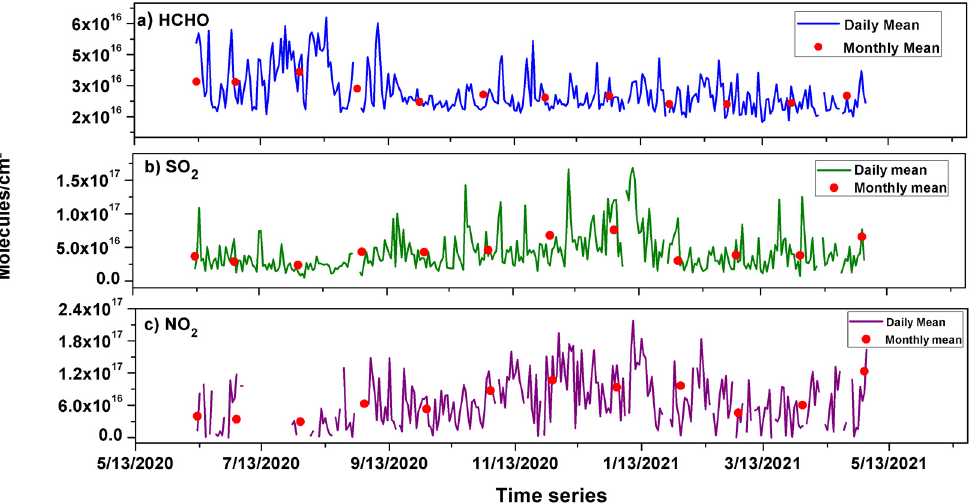
Figure 2. Daily and monthly averages of ( a ) HCHO, ( b ) SO 2 , and ( c ) NO 2 from June 2020 to May